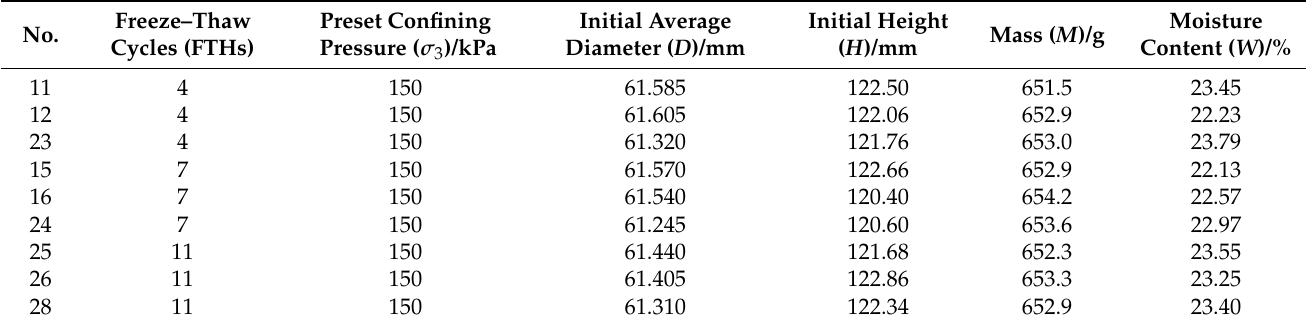
Table 2. Frozen–thawed cycle, preset confining pressure, geometrical size, mass and moisture content information of the remolded triaxial specimens.